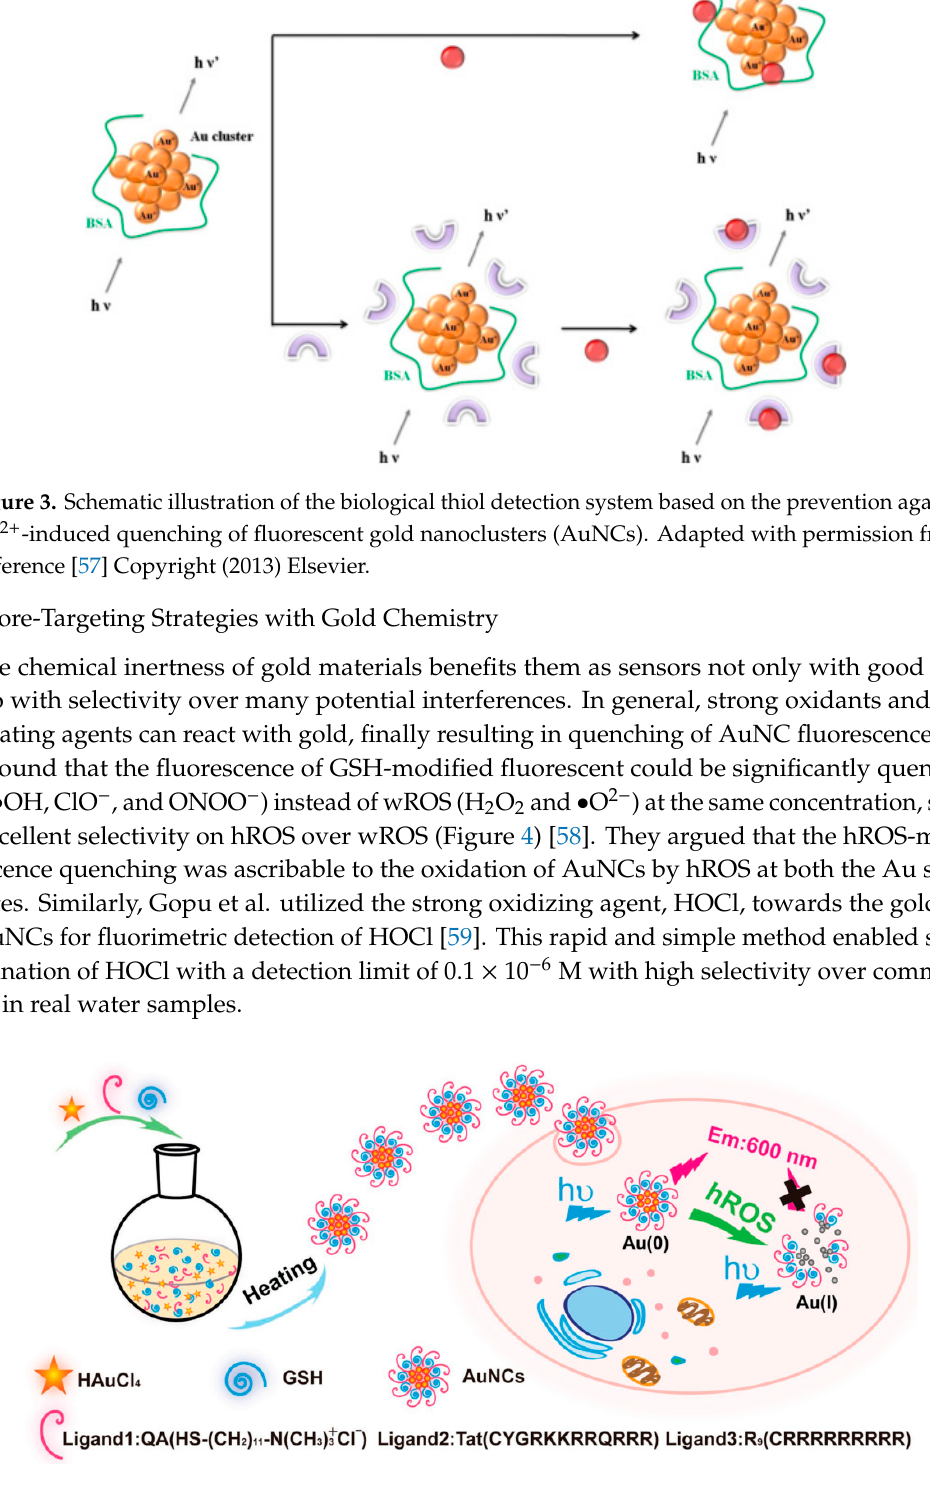
Figure 4. Schematic illustration of the one-step synthesis of red-emitting AuNCs with versatile surface chemistry, and the fluorescence quenching strategy for the living cell imaging of hROS (•OH, ClO − , and ONOO − ) using the functionalized AuNCs. Adapted with permission from Reference [58] Copyright (2018) Wiley.